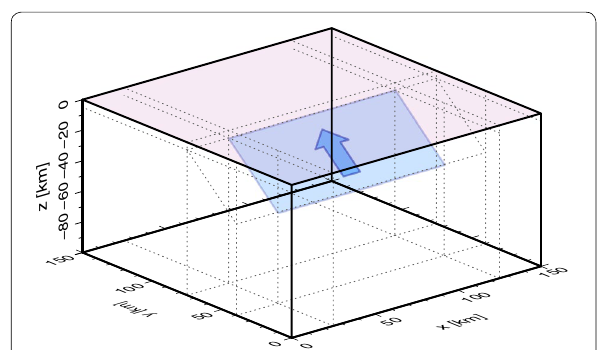
Fig. 13 Geometry of the finite-fault simulation used to infer the coseismic deformation. The blue rectangle shows the fault plane, and the red rectangle shows the free